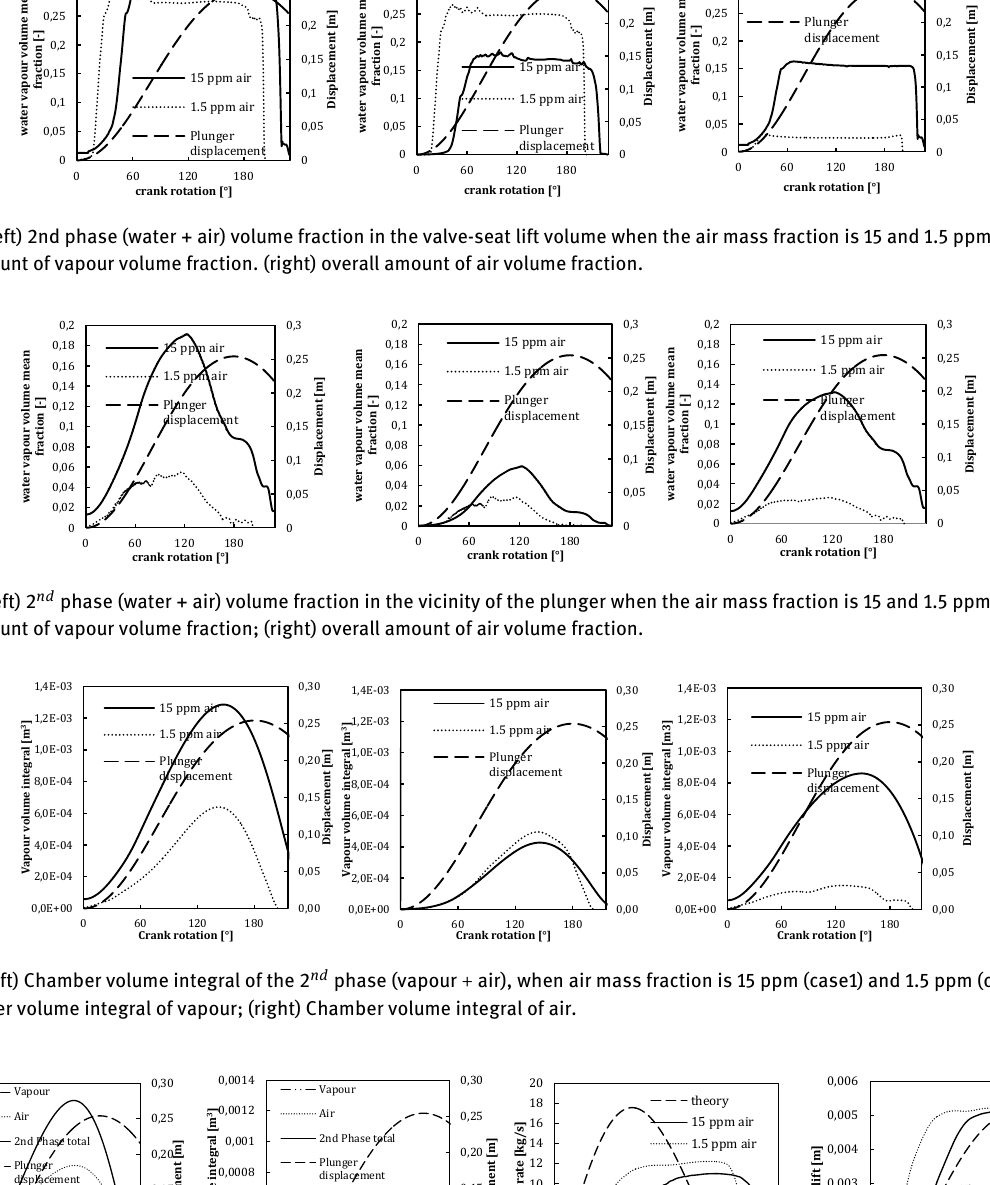
Figure 9. (left) Chamber volume integral of the second phase components Case number 1, air mass Figure 9: (left) Chamber volume integral of the second phase com- fraction 15 ppm. (right) Case number 2, air mass fraction 1.5 ppm. ponents Case number 1, air mass fraction 15 ppm; (right) Case num- ber 2, air mass fraction 1.5 ppm.